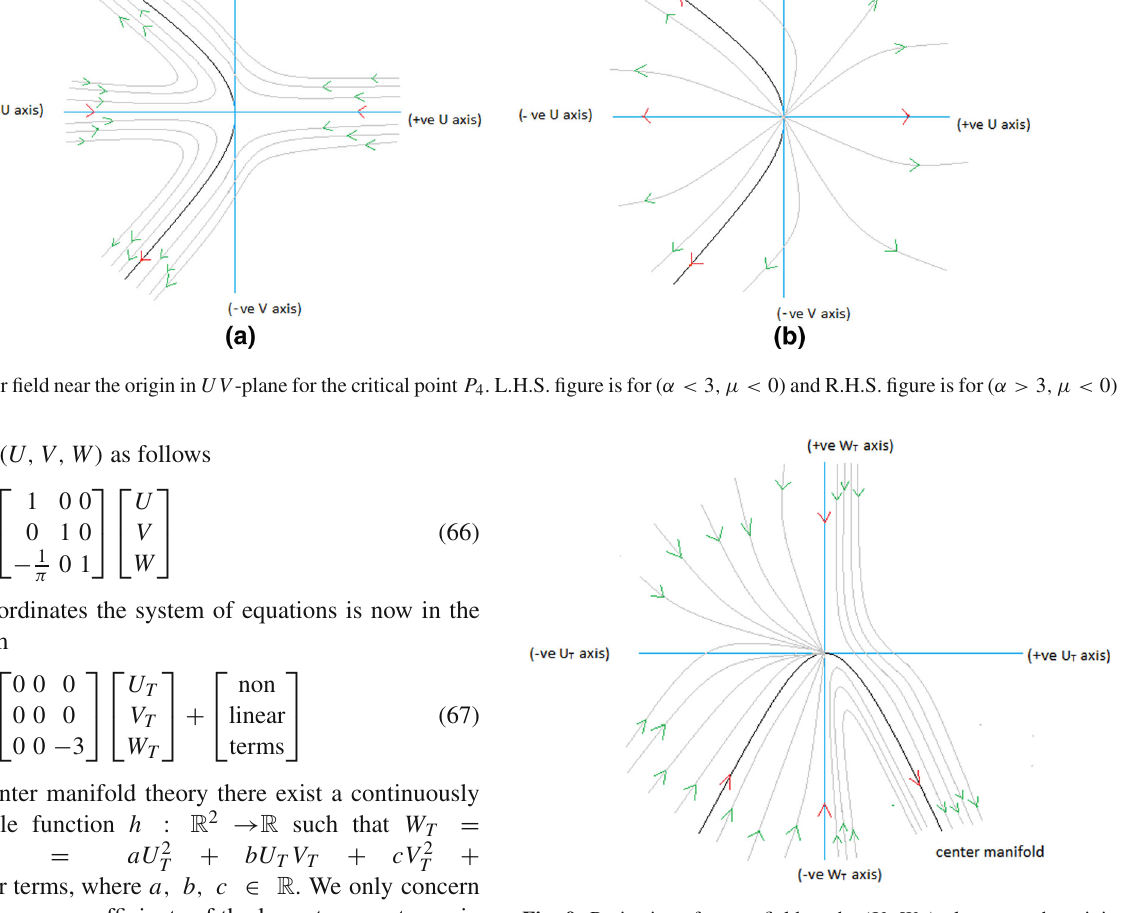
Similarly for analyzing the stability of this critical point, first we divide both sides of (70) by 6 and divide both sides of (71) by 3. Since we divided both sides of these equations by positive terms, so the direction of vector field is unchanged. + V 2 , then differentiating both sides with We take r 2 = U 2 T T respect to N and using (70) and (71) yields r (cid:4) = U T r . So r (cid:4) depends on the sign of U T . If U T > 0 then r (cid:4) > 0 and if U T < 0 then r (cid:4) < 0. So, the origin is a saddle node and hence the vector field near the origin is unstable in nature